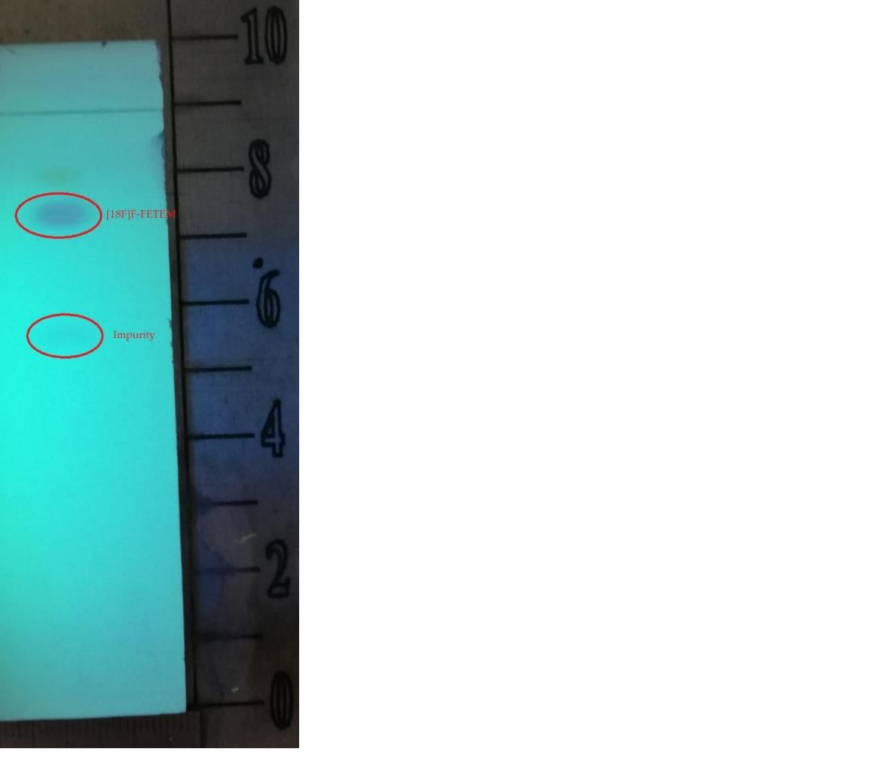
Figure 4. TLC analysis of chemical impurities of [ 18 F]F-FETEM detection in UV light at 254